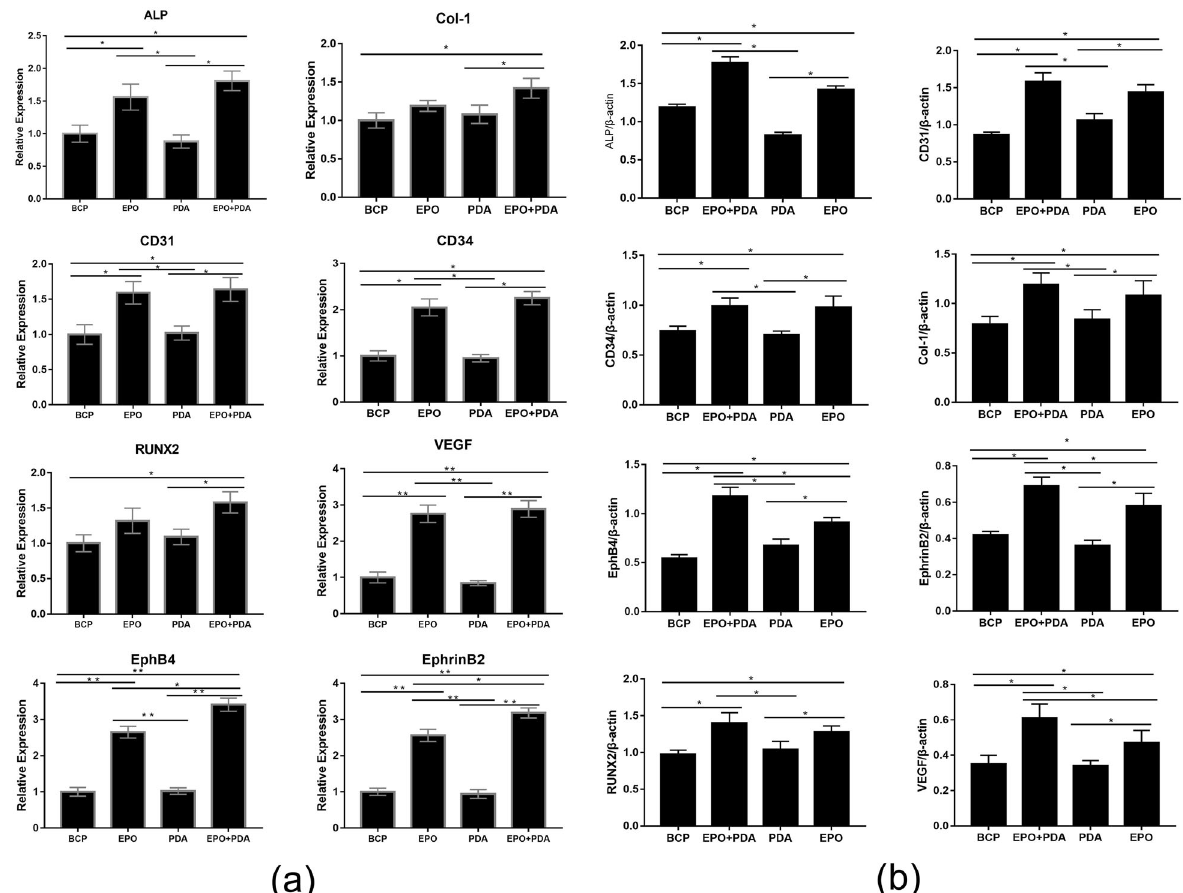
Fig. 6 a The expression of osteogenesis and angiogenesis-related genes and EphB4/EphrinB2 signaling pathways of co-cultured cells on different BCP bioceramics on day 7. (** p < 0.01, * p < 0.05). b Western-blot experiments showed the expression of osteogenesis and